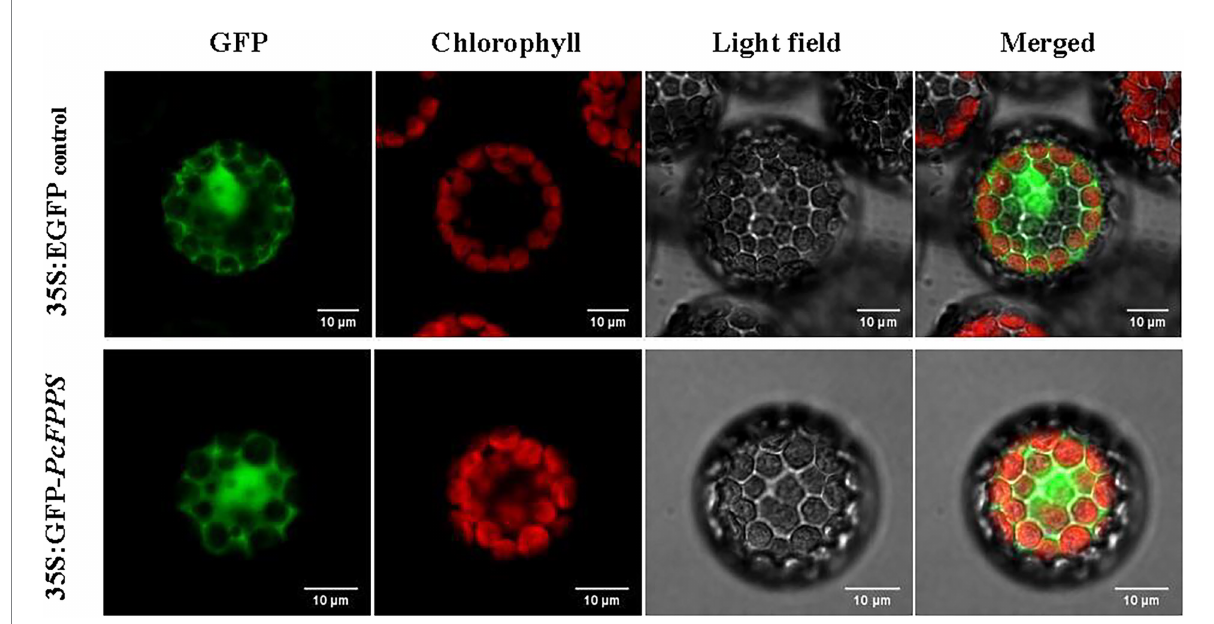
FIGURE 2 Subcellular localization of PcFPPS in Arabidopsis protoplasts. Control vector (35S:EGFP) and recombinant vector (35S:GFP- PcFPPS ) are expressed in protoplasts of Arabidopsis . GFP, GFP fluorescence; Chlorophyll, Chlorophyll fluorescence; Light field; and Merged, superposition of fluorescence and light field. Bars, 10 μ m.